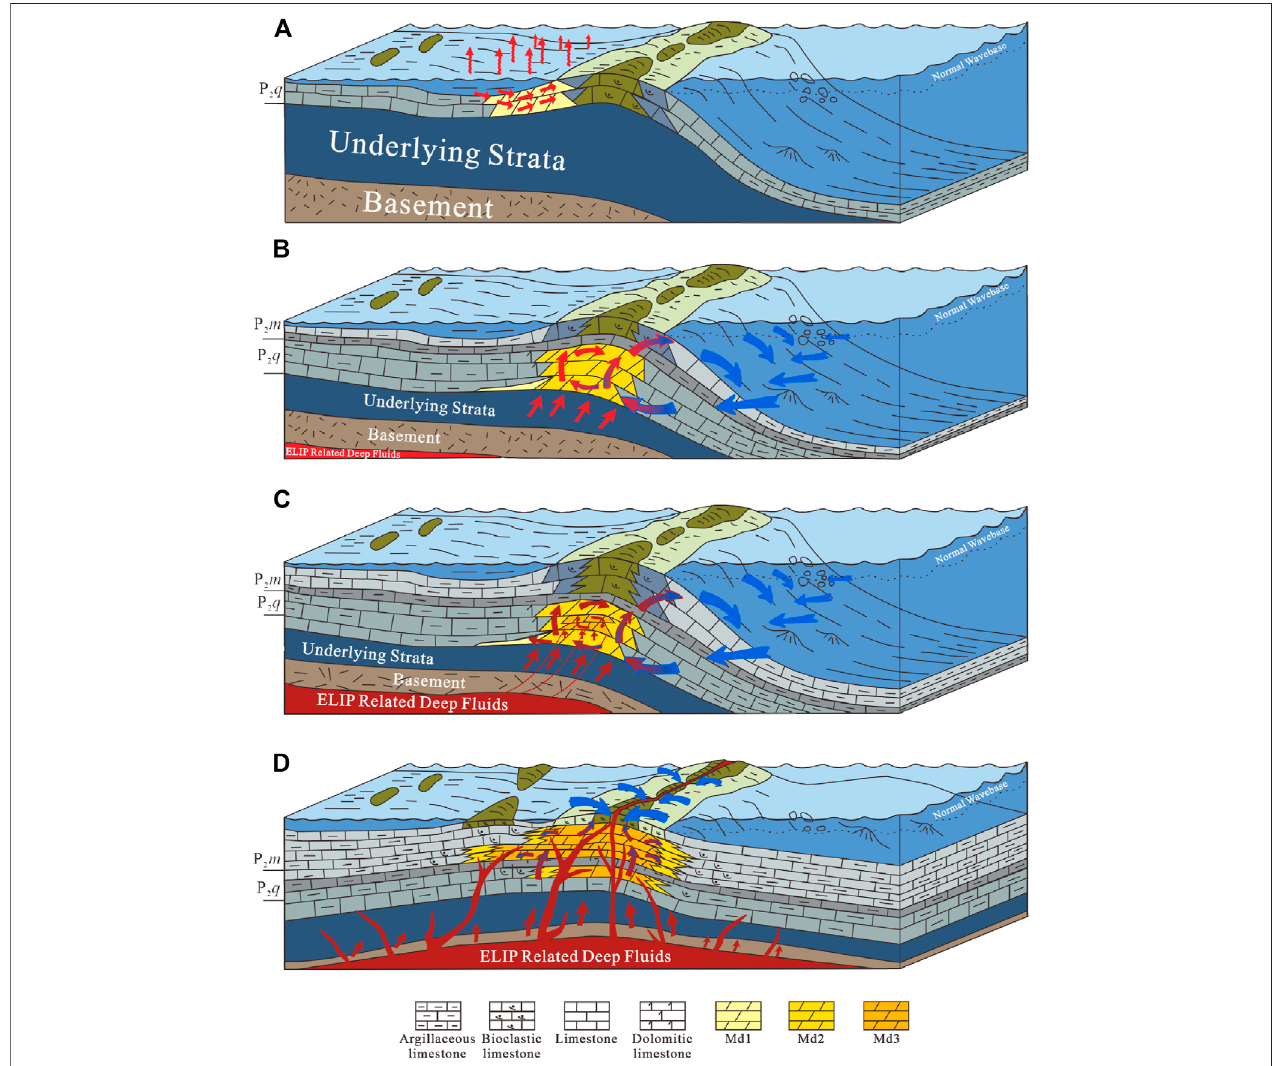
FIGURE 12 | Dolomitization pattern of the Middle Permian Formation in Western Sichuan Basin. (A) Seepage re fl ux dolomitization in the penecontemporaneous stage(Md1); (B) thermalconvectiondolomitizationintheshallowburialstage(Md2); (C) high-temperaturethermalconvectiondolomitizationinshallowburialstageinNW (Md3 and Cd); (D) deep fl uid participated in top and lateral open thermal convection at high temperature and structure-hydrothermal dolomitization in the shallow burial stage in SW (Md3 and Cd).